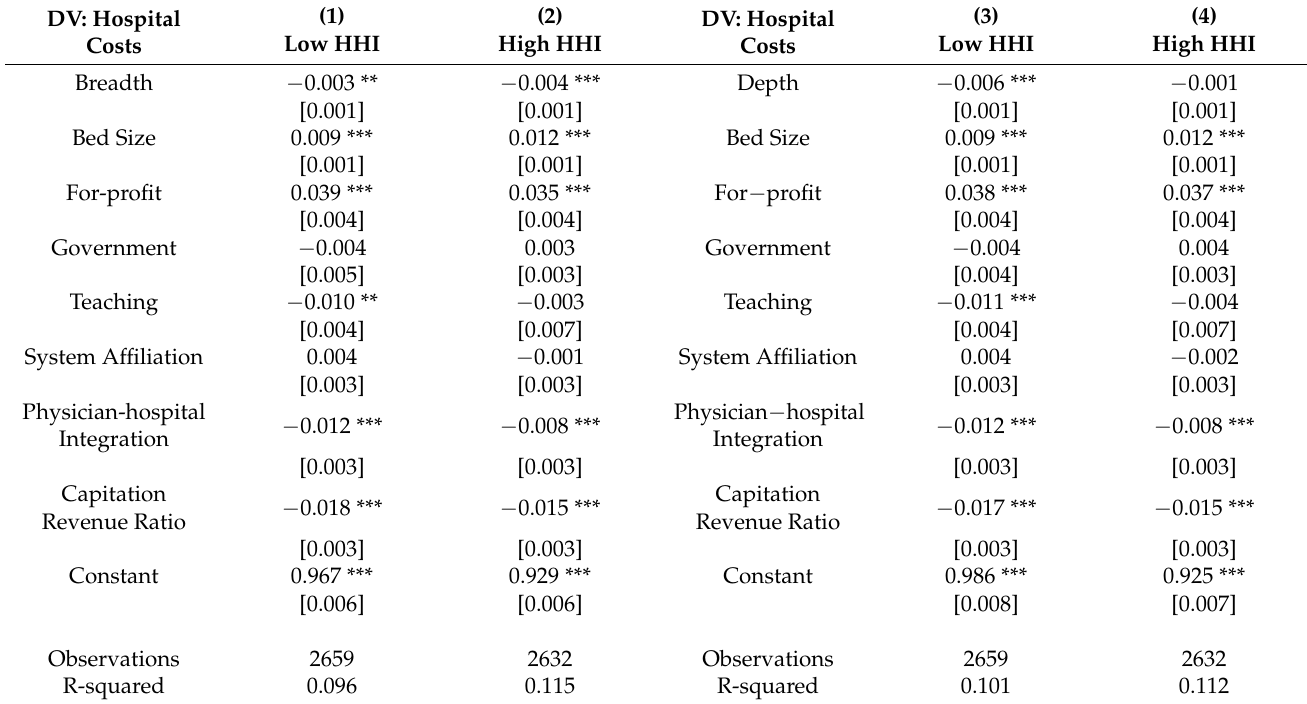
Table 4. The impact of health information sharing on spending by